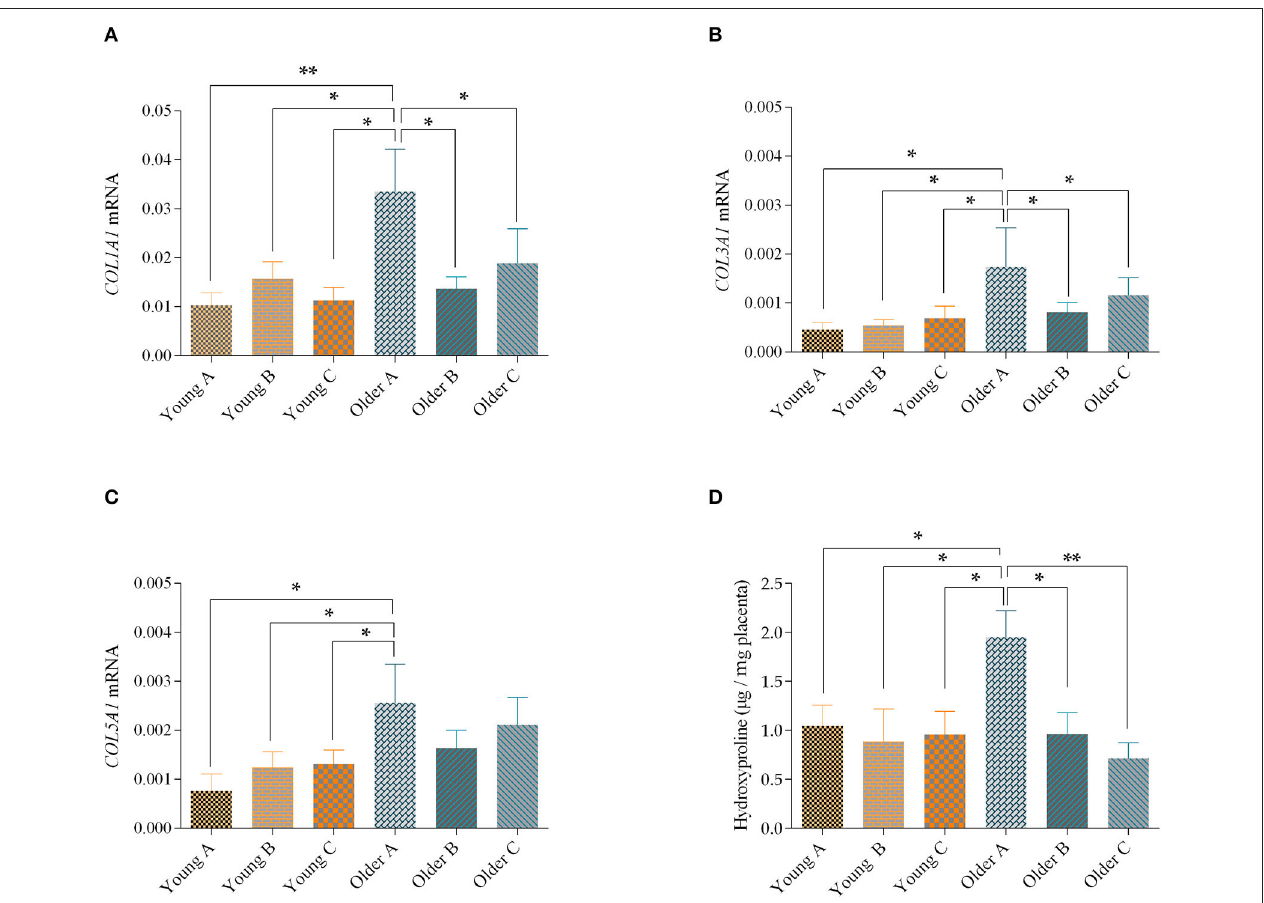
FIGURE 3 | Transcript levels of COL1A1 (A) , COL3A1 (B) and COL5A1 (C) and levels of hydroxyproline (D) in the gravid horn (A) , non-gravid horn (B) and body (C) of placentas from young and older mares. Bars represent the mean ± SEM. Asterisks indicate significant differences between the placental portions (* p < 0.05; ** p < 0.01). Data were analyzed by one-way ANOVA, followed by Fisher’s LSD